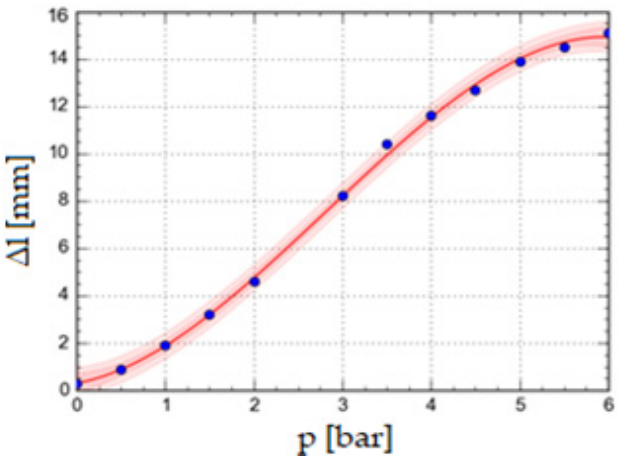
The parameters of the regression were found using a specialized software, the Curve Expert Professional v. 2.7, and based on the measured values. The correlation coefficient ( r ) is 0.999 and the coefficient of determination ( r 2 ) is 0.998. Those values validate the function. In Figure 6, the polynomial regression is presented, which best fits the obtained results at deflation.